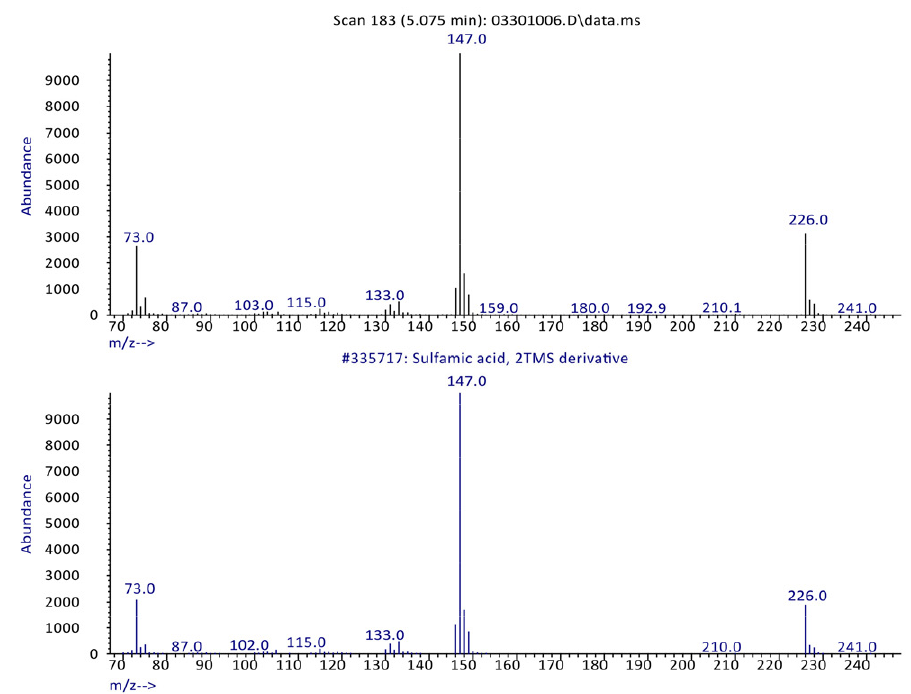
Figure 4. Mass spectrum comparison of sulfamic acid in sample 03 and Willey-NIST library mass spectral